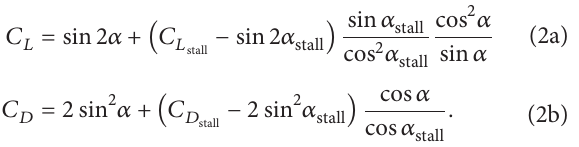
the range of 𝛼 investigated XFOIL consistently output lower 𝐶 𝐷 values.